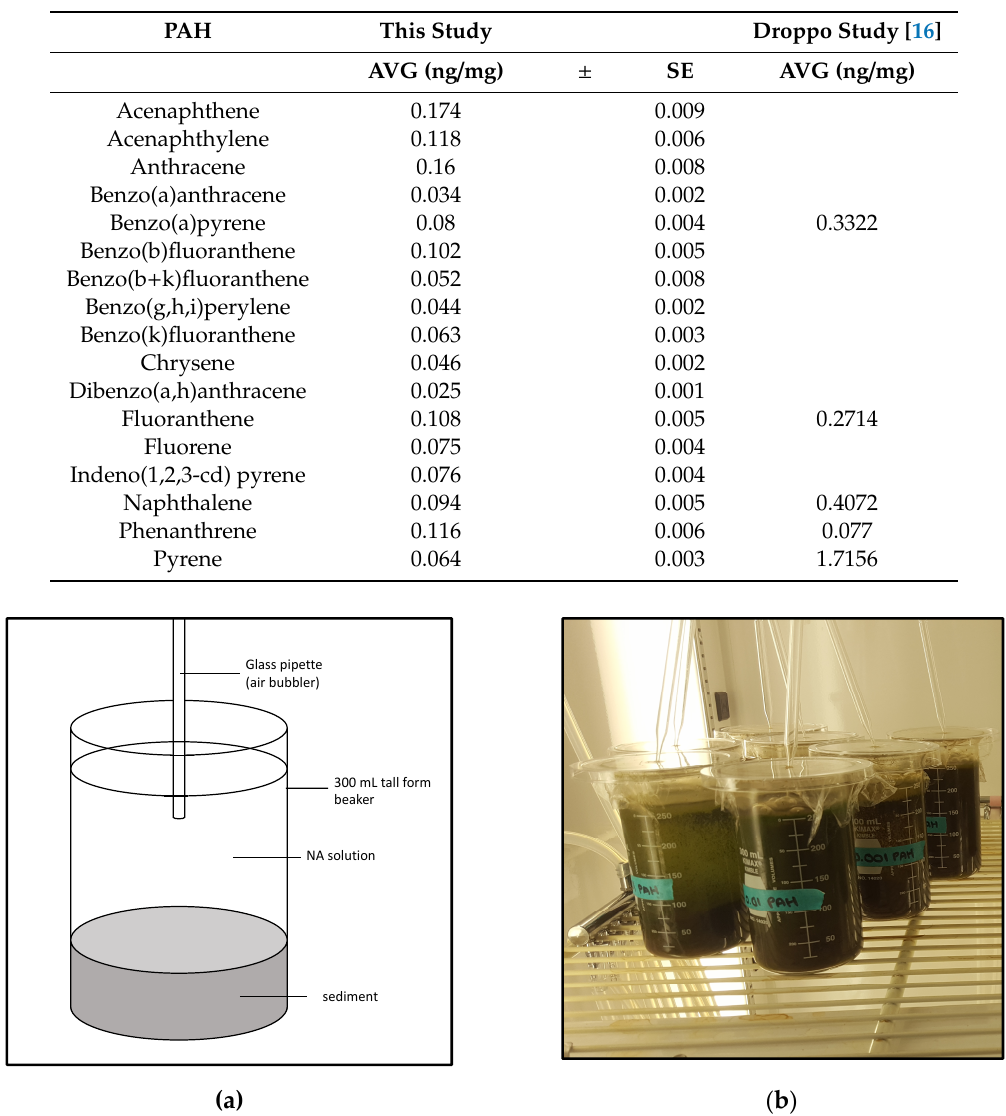
Table 2. Comparison of estimated actual (mean ± standard error [SE]) concentrations of 17 polycyclic aromatic hydrocarbons (PAH) present in spiked sediment tests used in this study versus field levels reported by Droppo et al. [16].